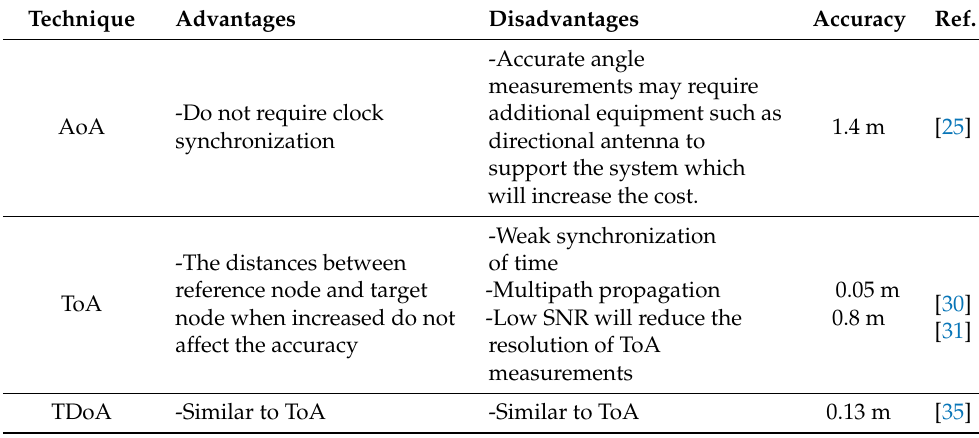
Table 2. Geometric Approach 3D Positioning Existing